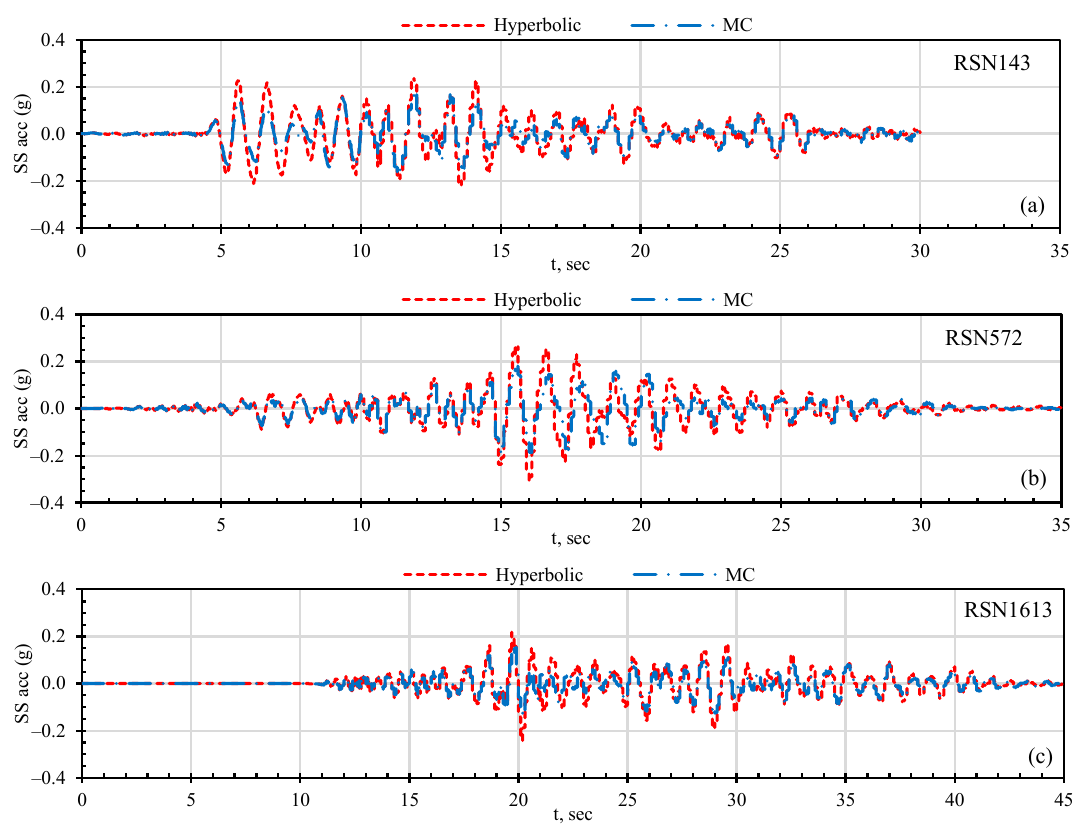
Figure 12. Acceleration time responses of the superstructure using Hyperbolic and MC models ( a )